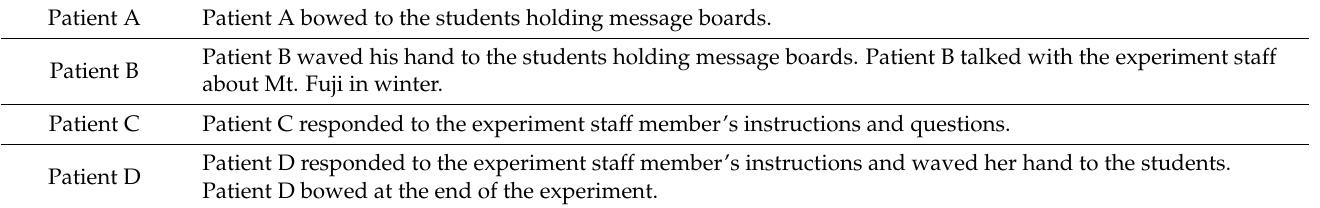
Table 11. Communication between the experiment staff and the patients in the preliminary out- door experiment.